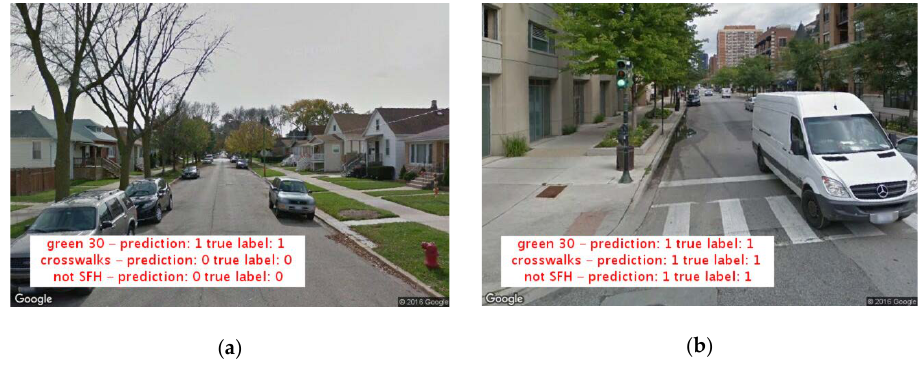
Figure 1. Example processed Google Street View images for green street, presence of crosswalks, and “not single family home” indicators.